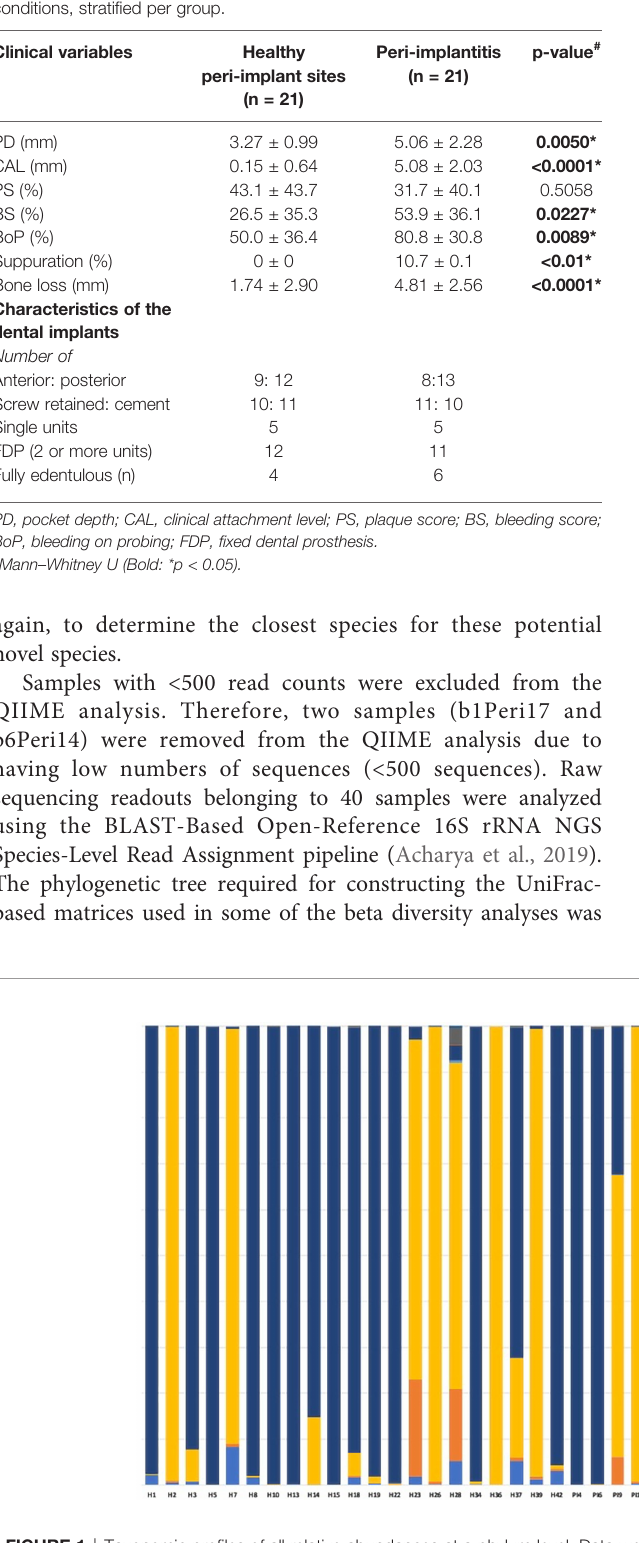
FIGURE 1 | Taxonomic pro fi les of all relative abundances at a phylum level. Data were normalized and displayed by sample. H, healthy peri-implant site samples; P, peri-implantitis